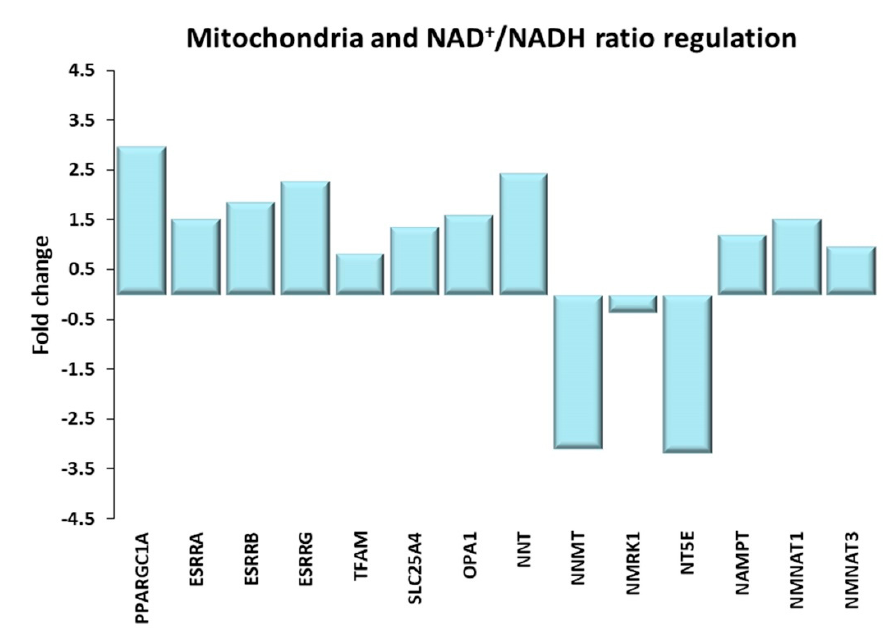
Figure 7. Mitochondria and NAD+/NADH ratio regulation. Genes discussed in the text are shown here as fold change in the comparison of TRA and SED subjects. PPARGC1A: proliferator-activated receptor γ coactivator-1 α or PGC1 α ; ESRRA, ESRRB, ESRRG: estrogen related receptors α , β , γ ; TFAM: mitochondrial transcription factor A; SLC25A4: solute carrier family 25 member 4 or ANT1; OPA1: OPA1 mitochondrial dynamin like GTPase; NNT: nicotinamide nucleotide transhydrogenase; NNMT: nicotinamide N-methyltransferase; NMRK1: nicotinamide riboside kinase 1; NT5E: 5 ′ - nucleotidase ecto; NAMPT: Nicotinamide Phosphoribosyltransferase; NMNAT1, NMNAT3: Nicotinamide Mononucleotide Adenylyl Transferase 1, 3.